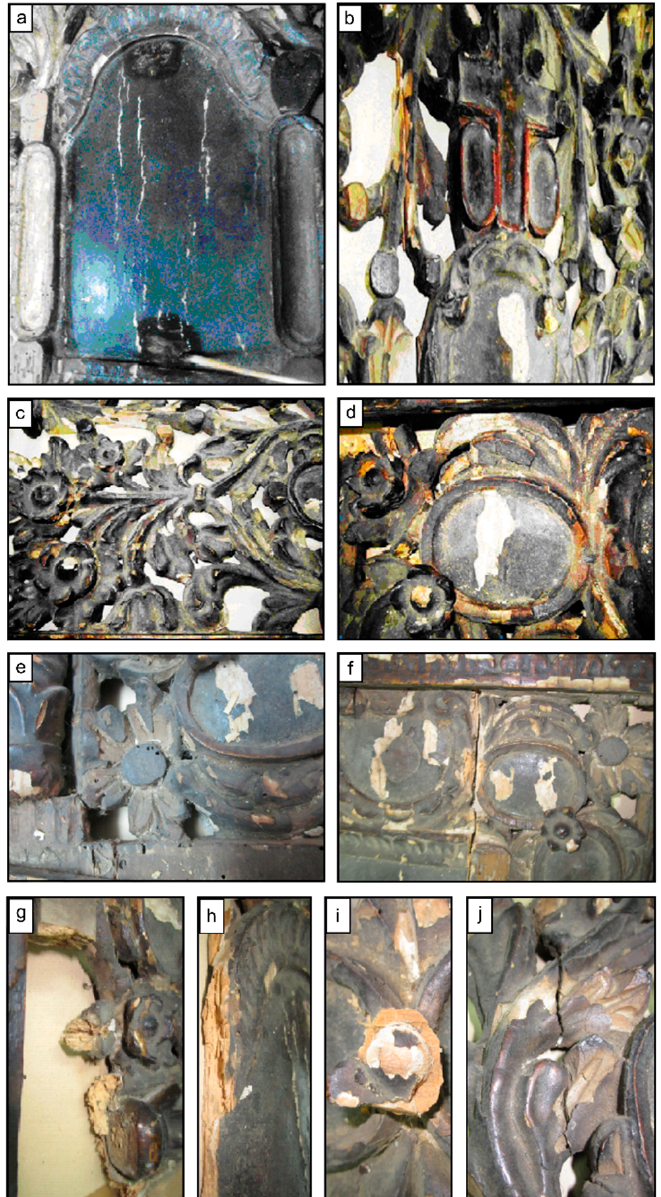
Figure 2. Details of the icon with deteriorations and degradations: ( a ) Degradation by oxidative fouling and deterioration by dynamic longitudinal cracks with roofing degradations in the central medallion; ( b – f ) Superficial and profound lacunae, oxidative incrassation and missing ornament through fraction and loss; ( d – f ) Central lacuna in medallions and ornament; ( g – j ) Advanced weakening by xylophagic attack, deep longitudinal and transverse cracks, pictorial and support materials loss.